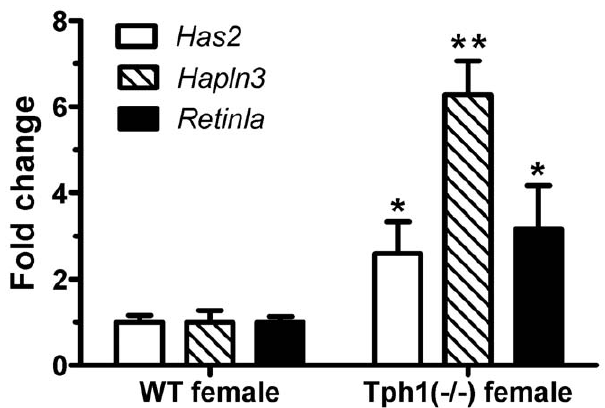
Figure 1. Quantitative real-time PCR was conducted as described in MATERIALS AND METHODS with pulmonary tissue harvested from WT and Tph1 ( 2 / 2 ) female mice (n=6). *p , 0.05, **p , 0.001 when compared to WT (ANOVA).